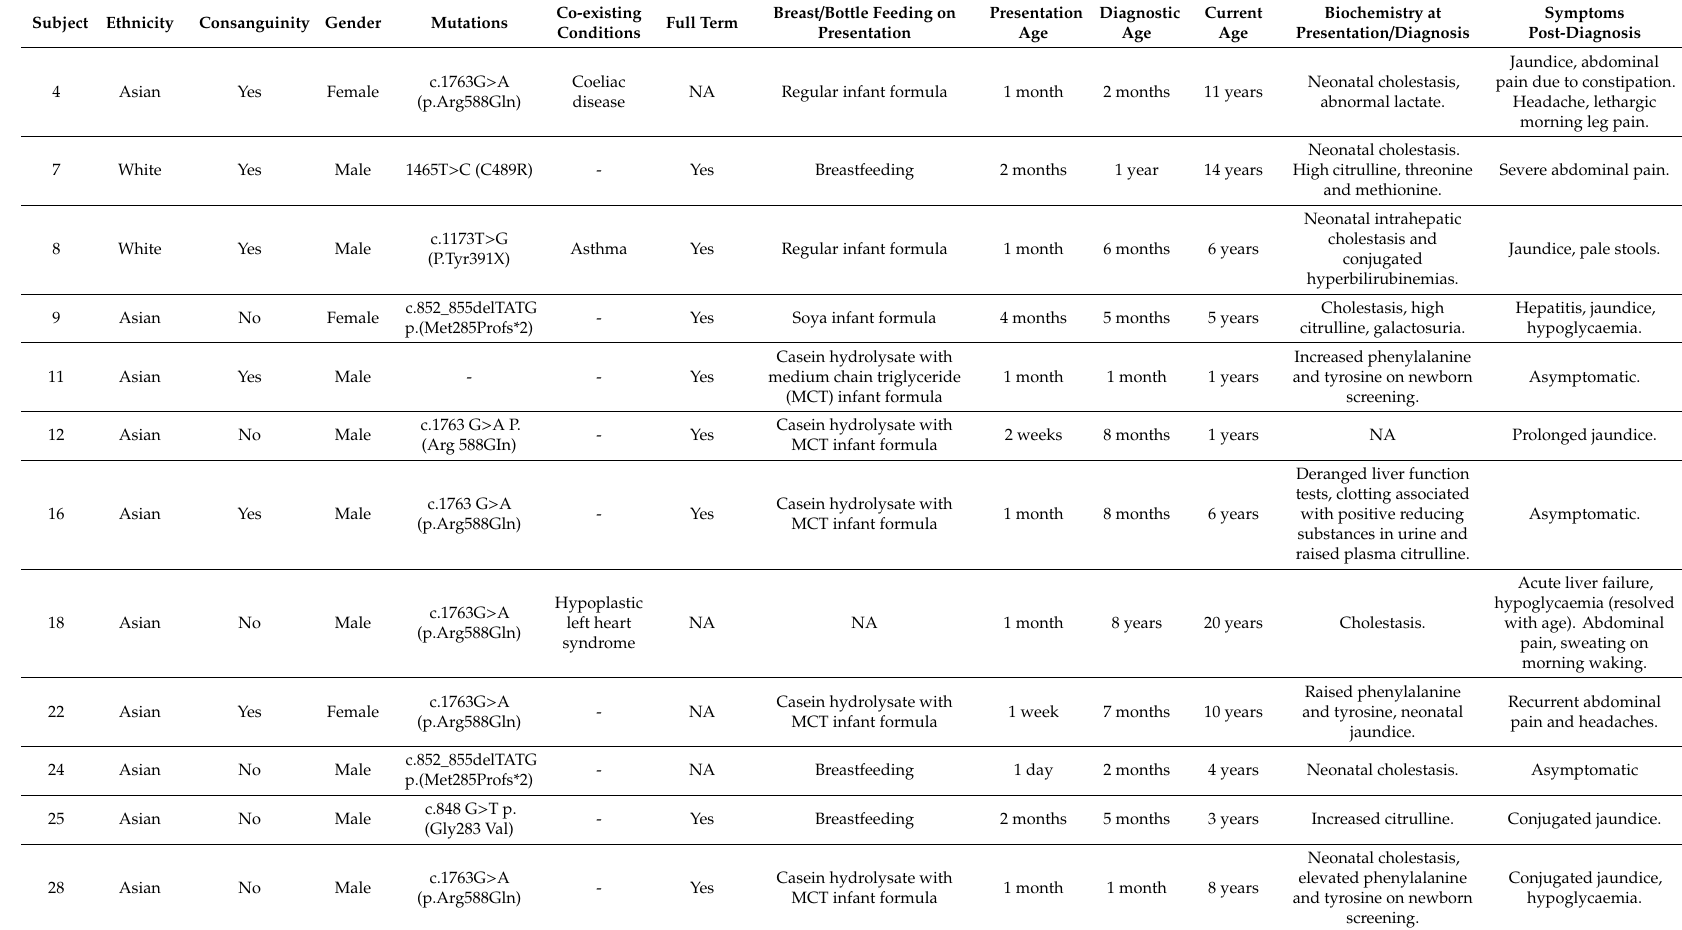
Table 2. Demographics, genetic results and symptoms on presentation for NICCD